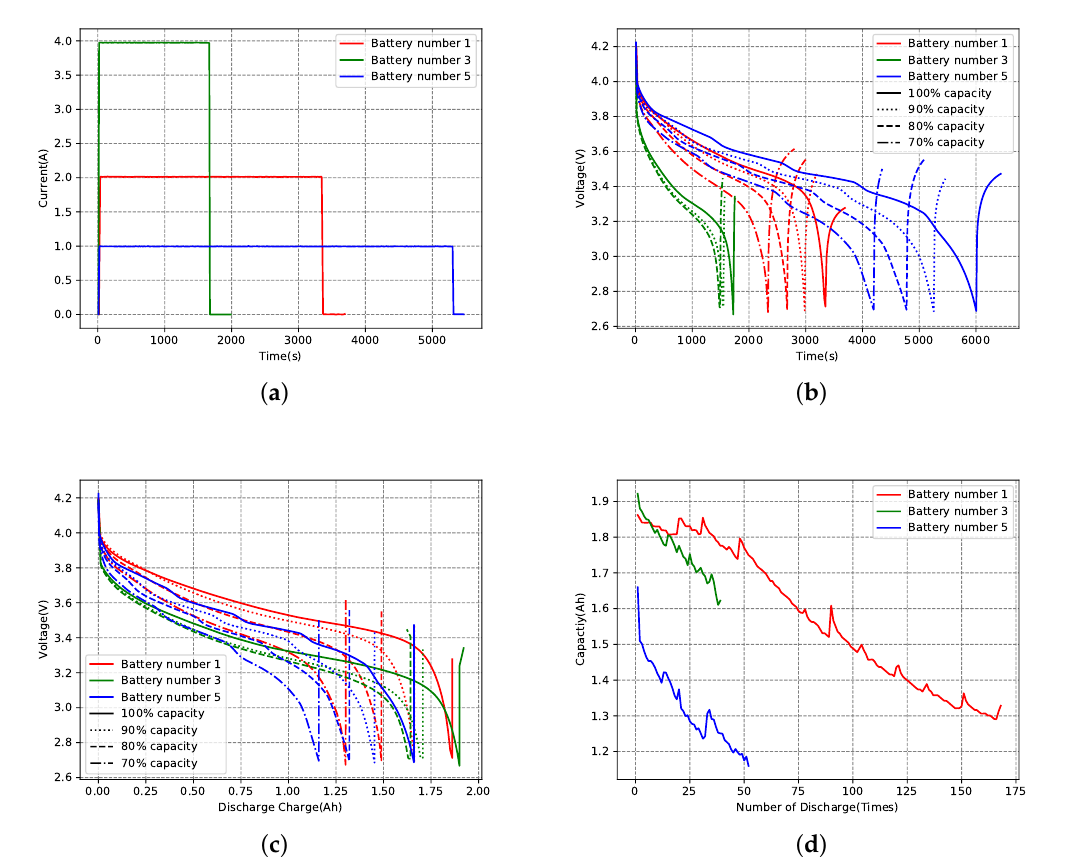
Figure 9. Experimental data. ( a ) Discharge current curve. ( b ) Voltage curve under different aging degrees. ( c ) Relationship between voltage and discharge charge under different aging degrees. ( d ) Discharge charge curve under different discharge